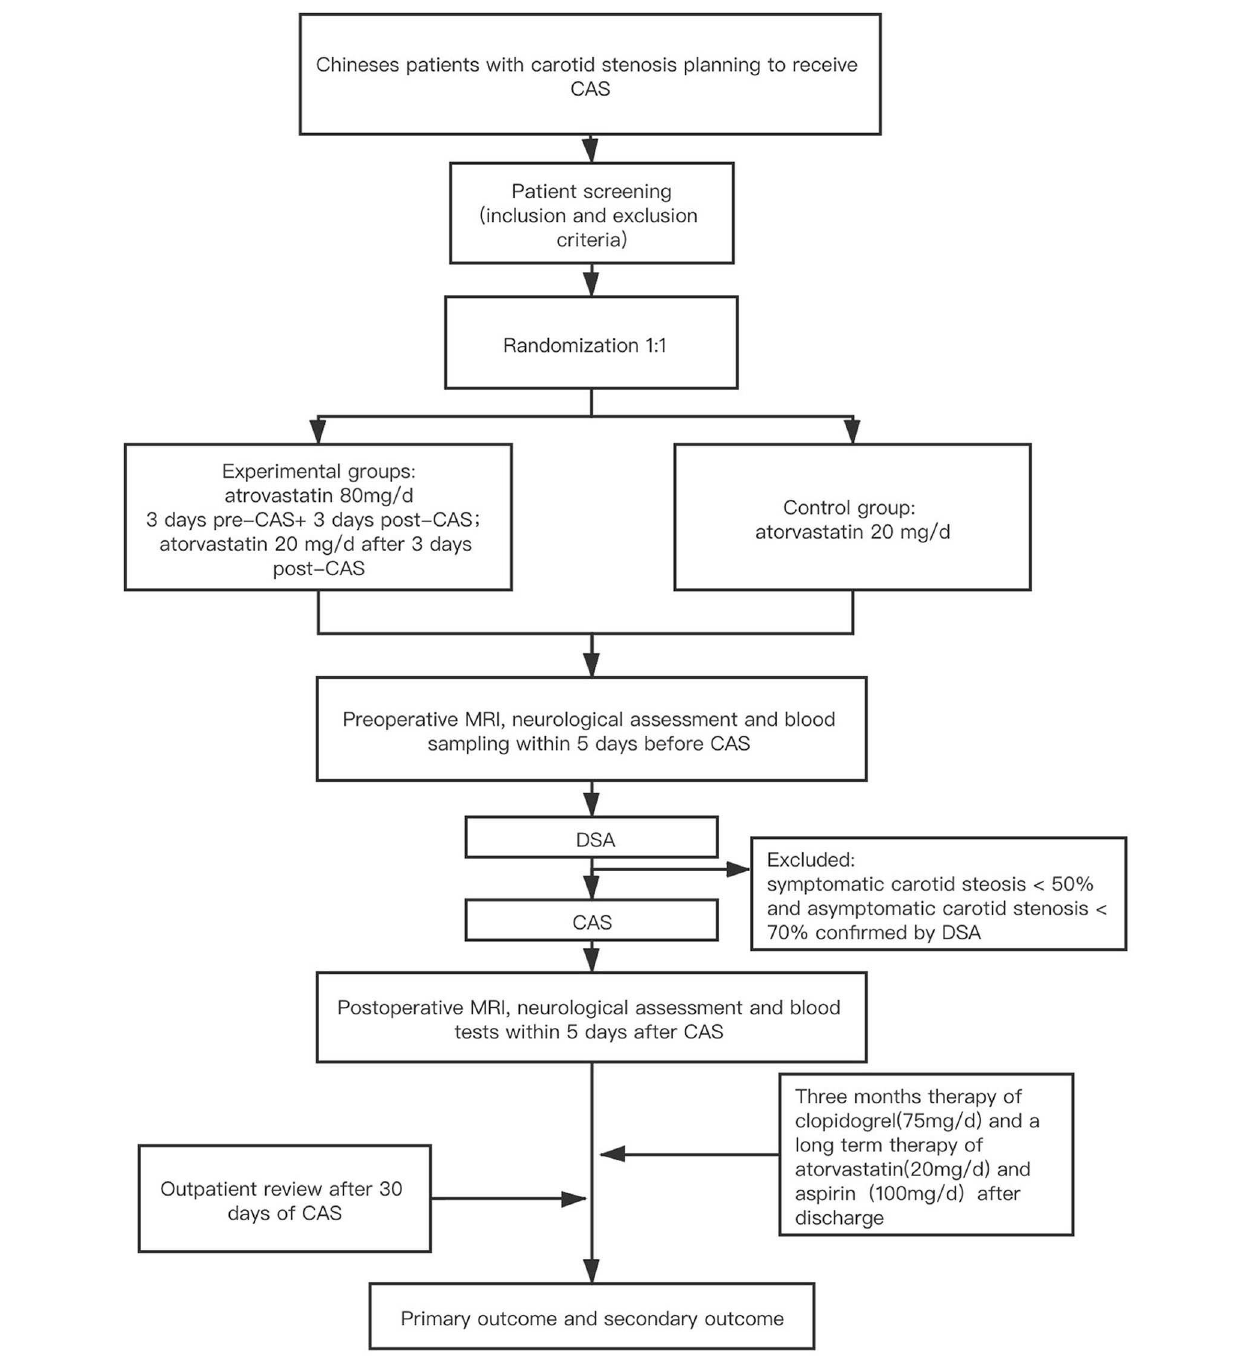
FIGURE 1 | Study design. CAS, carotid artery stenting; MRI, magnetic resonance imaging; DW-MRI, diffusion-weighted magnetic resonance imaging.